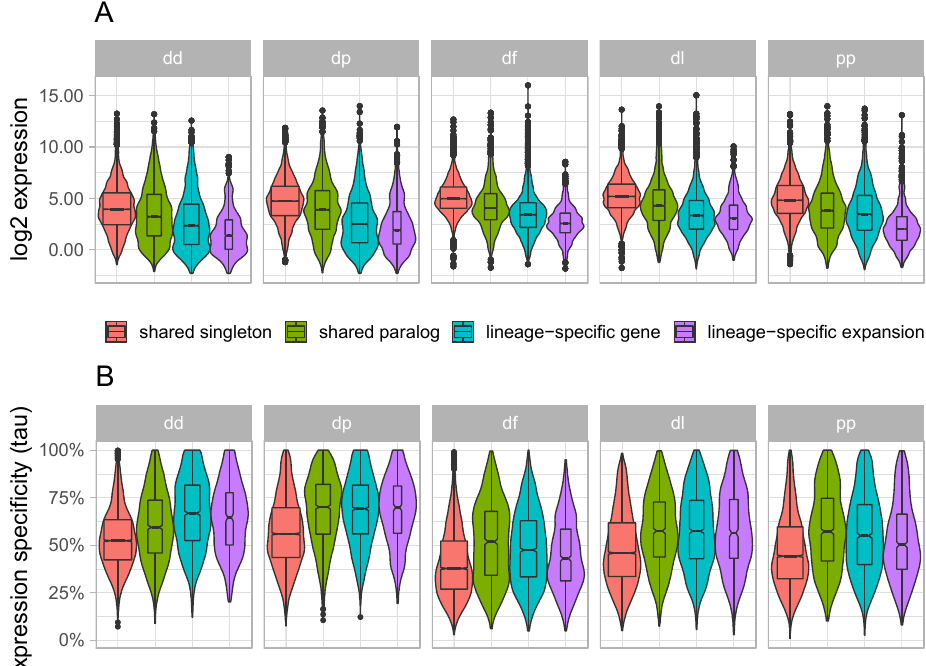
Figure 1. Gene expression distributions across gene categories for each of five dictyostelid species (listed in Table 1). Violin plots of ( A ) gene expression (log2 TPM) and ( B ) expression specificity (tau) for shared singletons (red), shared paralogs (green), lineage-specific genes (blue), and lineage-specific expansions (purple). dd: Dictyostelium discoideum ; dp: Dictyostelium purpureum ; df: Dictyostelium fasciculata ; dl: Dictyostelium lacteum ; pp: Polysphondylium pallidum .